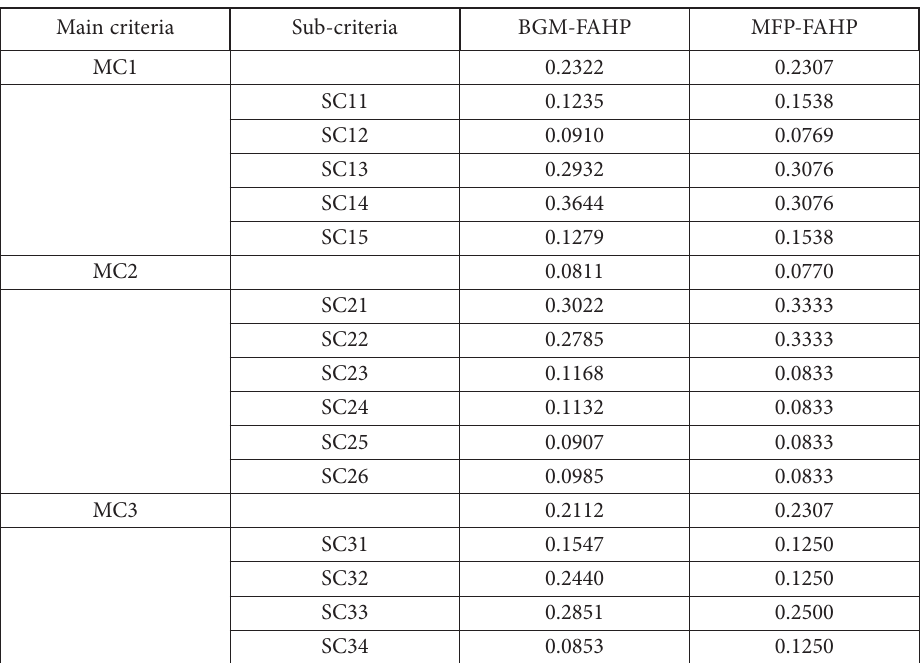
Table 8. The weights of the main criteria and its related sub-criteria Main